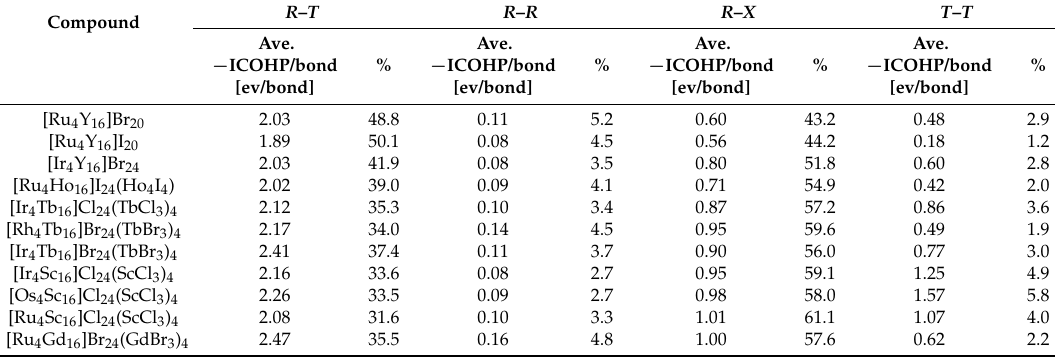
Table 2. Average − ICOHP/bond values and percentages of the respective interactions to the net bonding capabilities in rare-earth transition-metal halides comprising tetrameric clusters, [ T 4 R 16 ]. The details regarding the quantum chemical computations, distance ranges, − ICOHP/bond ranges and cumulative − ICOHP/cell values of all compounds listed in Table 2 have been reported elsewhere [59].